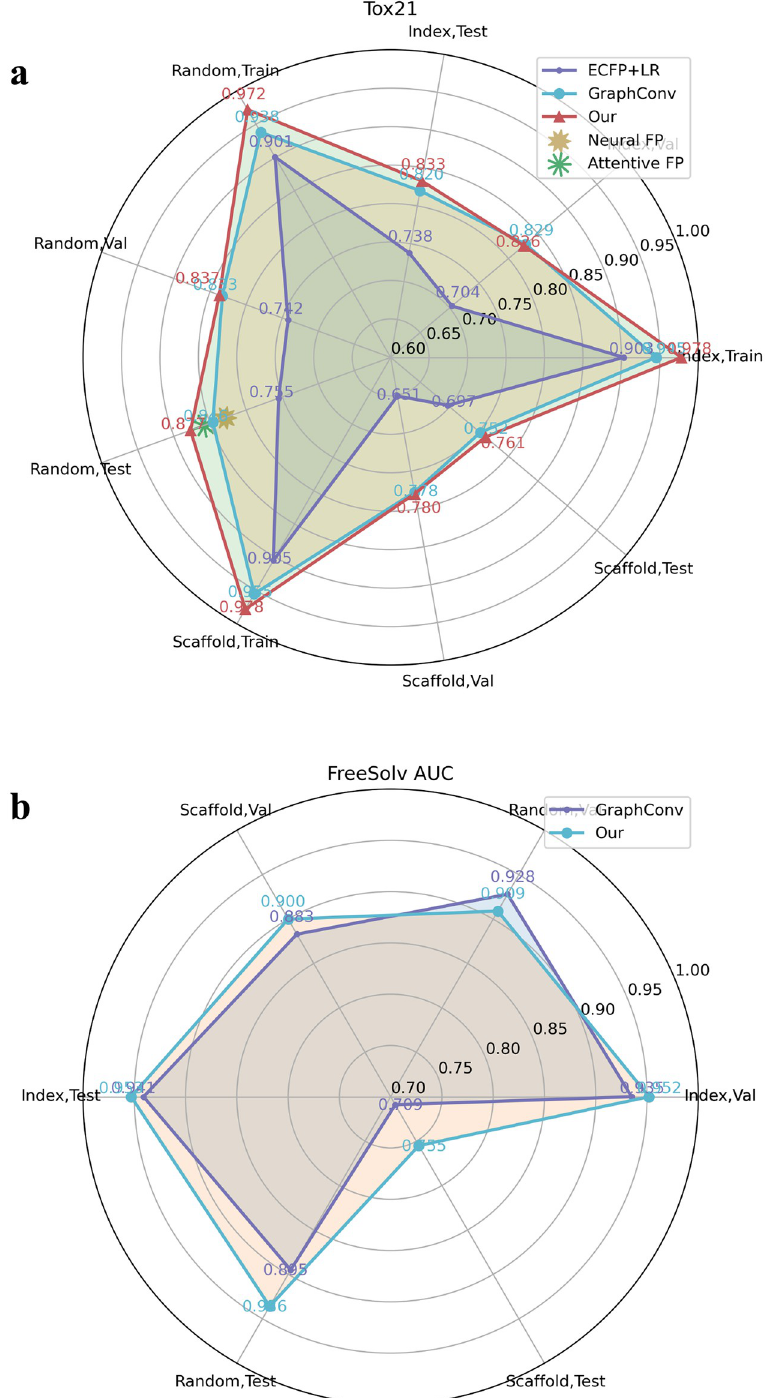
Fig 5. Performance comparison between our model and the baseline model in multitask classification and regression tasks. The area under the curve (AUC) of the ROC curve of various models in the a Tox21 and b Freesolv